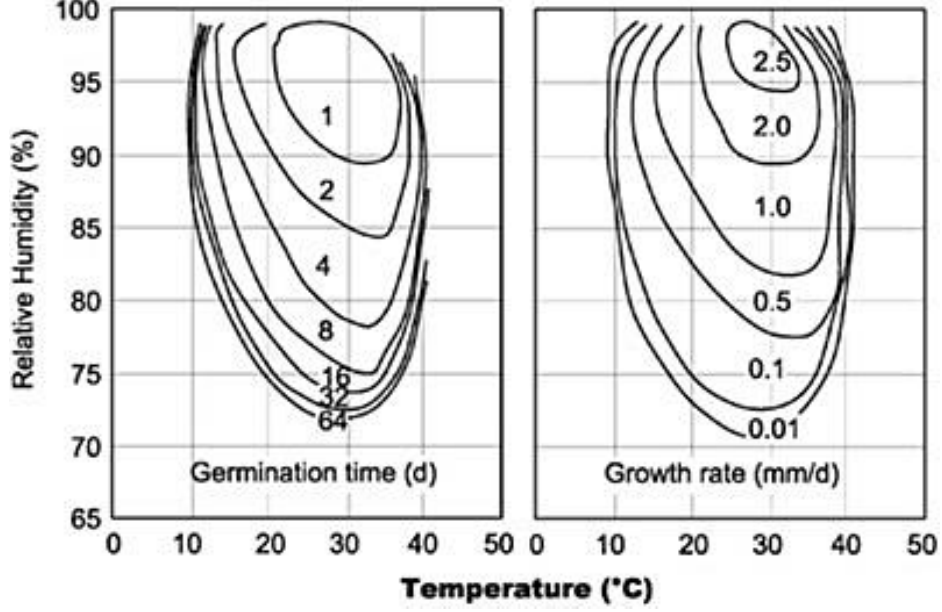
Figure 2. Mould germination and growth rate as a function of t and relative humidity (RH) [56].